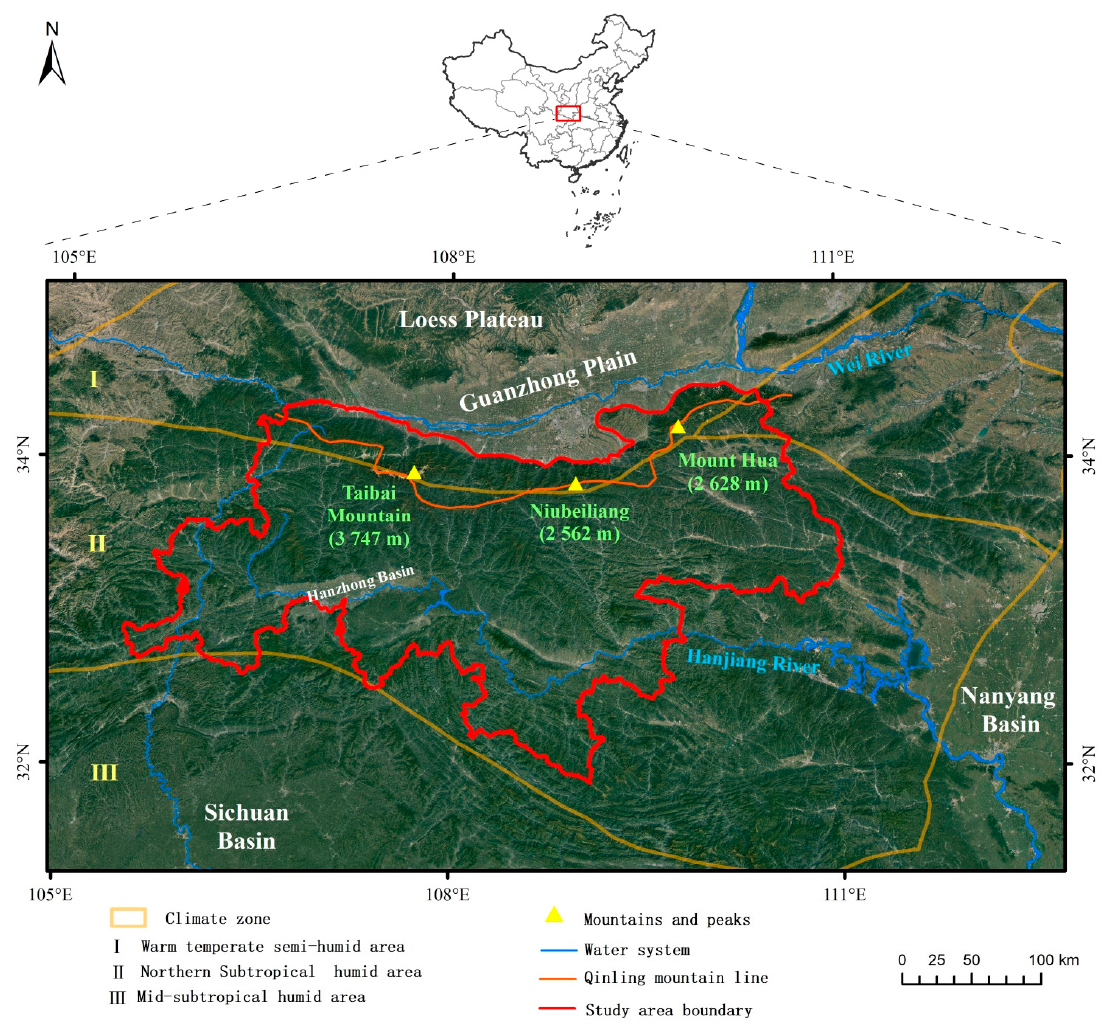
Figure 1. Geographical location of the study area. Qinling Mountains in Shaanxi Province, China. Qinling Mountains represent a climatic and geographic transition zone between south and north China [36], and between warm temperate and subtropical climates. Moreover, China’s 0° isotherm passes through this region. As a result, large-scale dif- ferences in climate (Figure 2a,b), plants [42,43], soil, and agricultural land use exist be- tween north and south regions of the Qinling Mountains [10,44]. Specifically, the climate is dry in the north and wet in the south. In addition, the elevation gradually increases from east to west and the topography of Qinling Mountains is characterized by moun- tains and hills [45] (Figure 2c). Slightly acid yellow-brown soil developed from granitic gneiss dominates in the south, while calcareous soil dominates in the north [40]. The forest cover of the study area exceeds 70%, and its distribution of vegetation types also presents an obvious transition from the north to the south (Figure 2d) [46], with the north slope dominated by warm temperate deciduous broad-leaved forests and the south slope characterized by deciduous broad-leaved forests mixed with evergreen spe- cies [28]. Further, from the north to the south of the Qinling Mountains, evergreen for- ests occur at lower elevations, while the larch forest belt is distributed across higher ele-